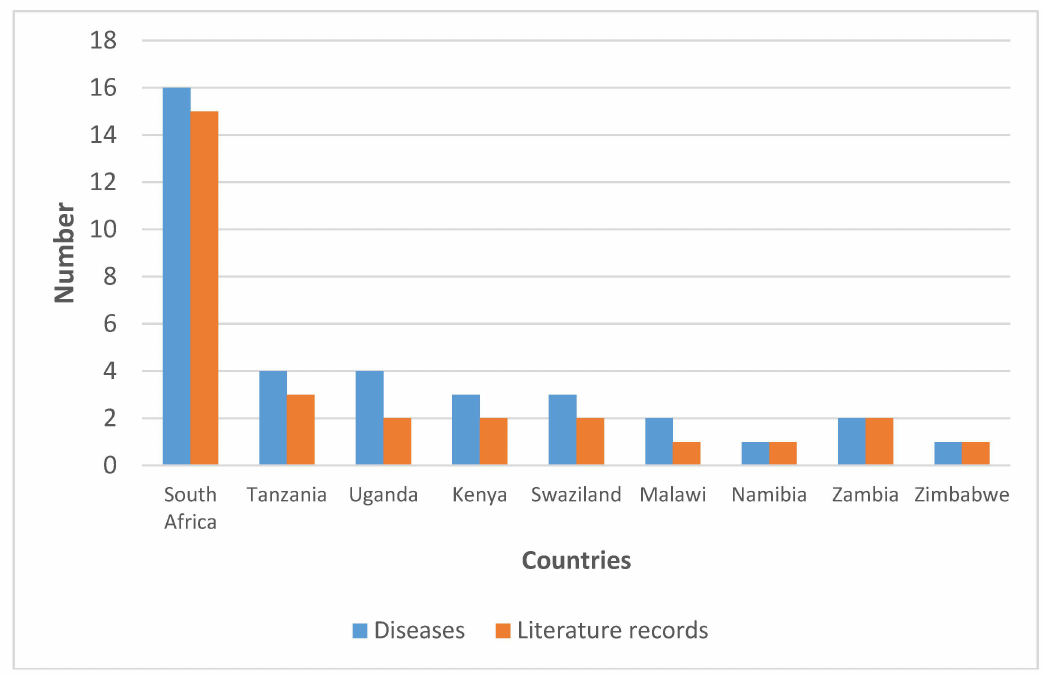
Figure 1. Diseases and ailments treated by Syzygium cordatum in east and southern